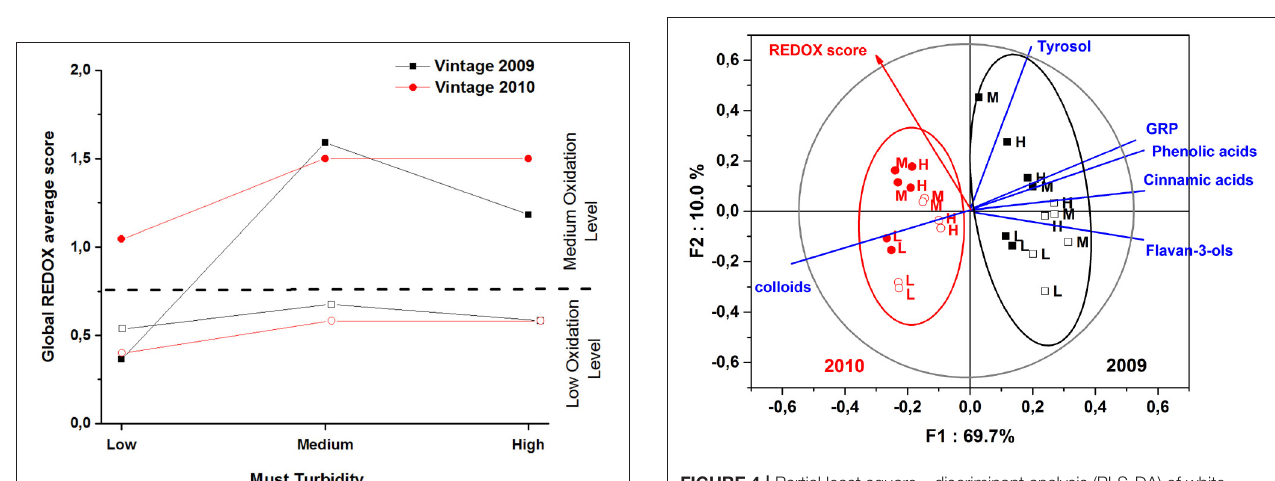
FIGURE 4 | Partial least square—discriminant analysis (PLS-DA) of white wines elaborated from three different must turbidity: low (L), medium (M), and high (H) for vintages 2009 (black) and 2010 (red), and the two types of bottle closures: synthetic coextruded stopper (filled square and circle symbols) and screw cap (open square and circle symbols). Scores and loadings plots of the PLS-DA analysis of the REDOX sensory scores averaged for each sample as a function of the polyphenolic and colloidal